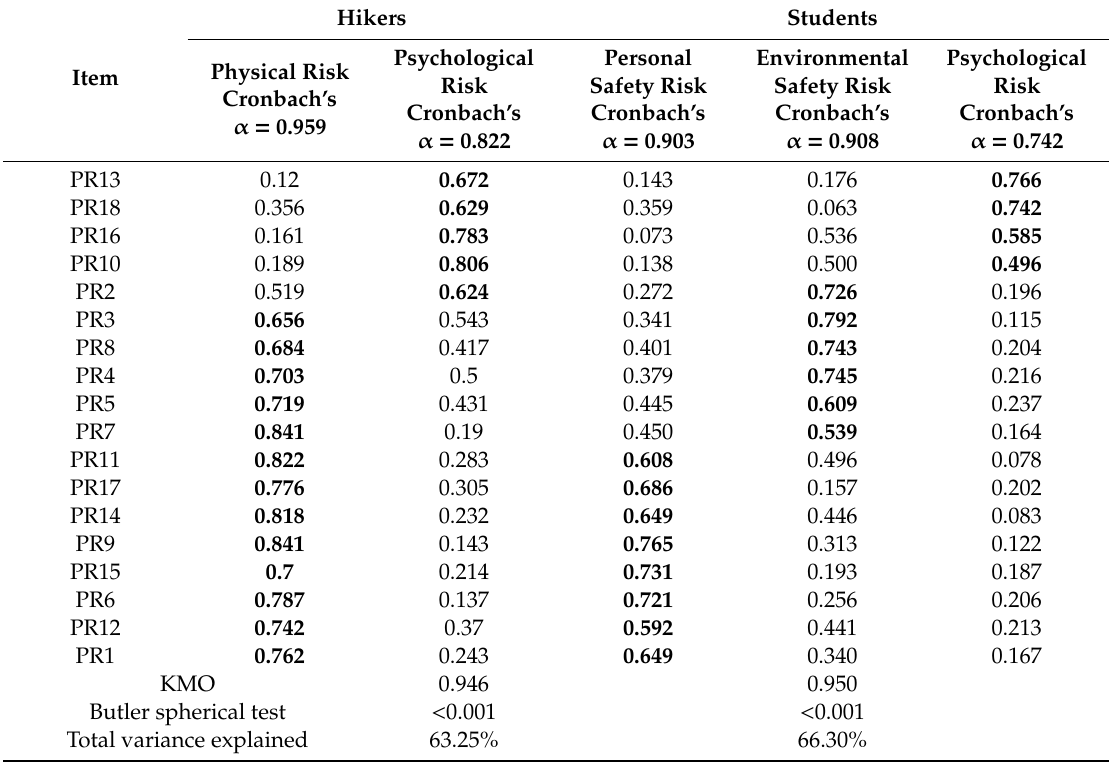
Table 4. Factor structures of perceived risks of